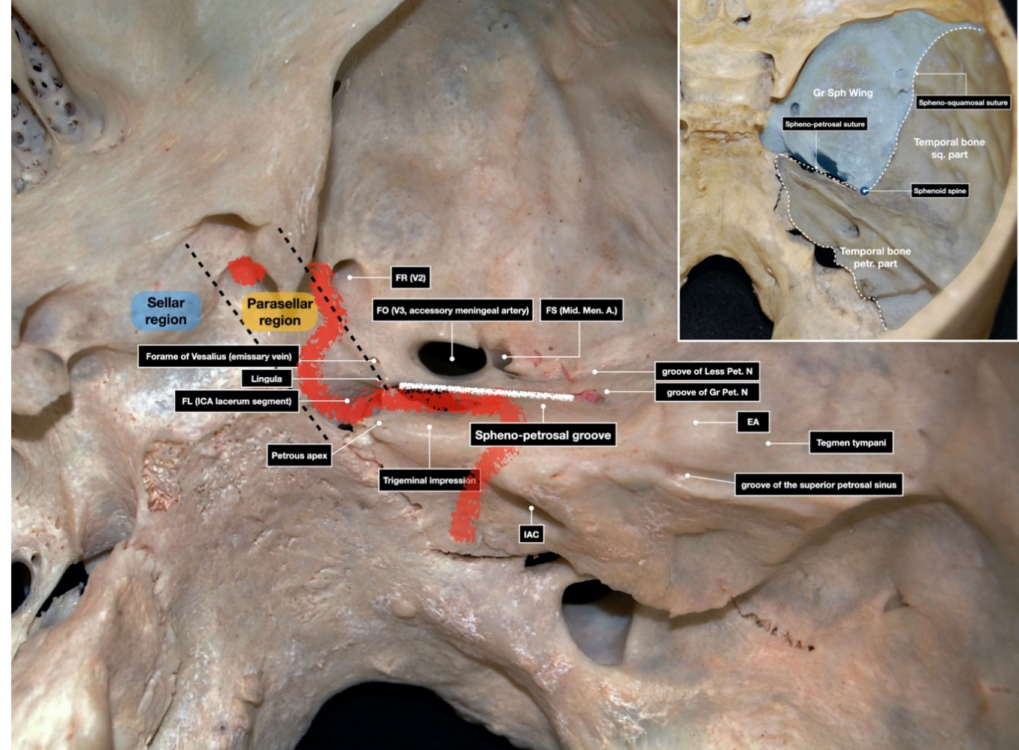
Figure 1. Main bony landmarks of the middle and posterior skull base. The red and white lines mark the course of the internal carotid artery and spheno-petrosal groove, respectively. EA: Eminentia Arcuata; FL: Foramen Lacerum; FO: Foramen Ovale; FR: Foramen Rotundum; Gr Sph. Wing: Greater Sphenoid Wing; Gr. Pet. N.: Great Petrosal Nerve; IAC: Internal Auditory Canal; ICA: Internal Carotid Artery; Less. Pet. N.: Lesser Petrosal Nerve; Mid. Men. A.: Middle Meningeal Artery; Temporal Bone sq. part: Squamosal part of the temporal